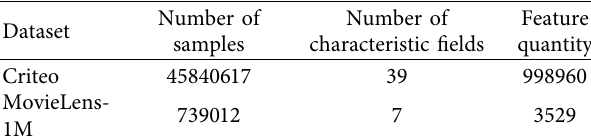
Table 2: Basic numerical statistics of dataset.